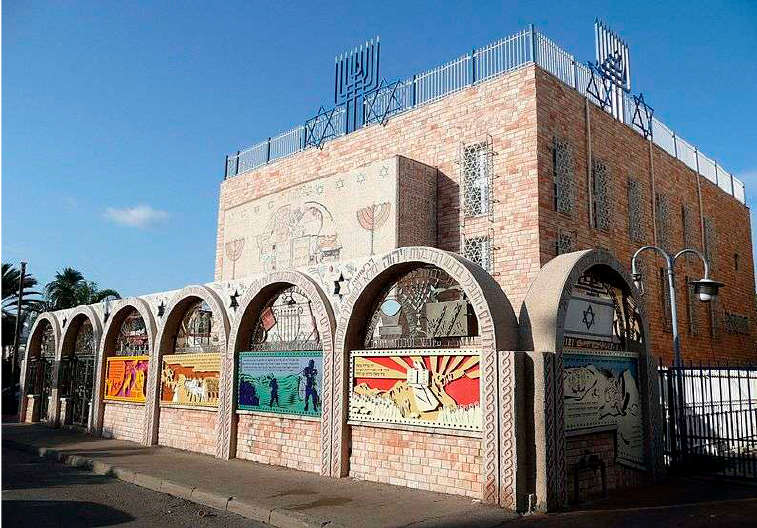
Figure 2. Panel in front of the Bar Ashi ( ישארב ) synagogue in Jerusalem (photo: Rafi Kfir, 2015).